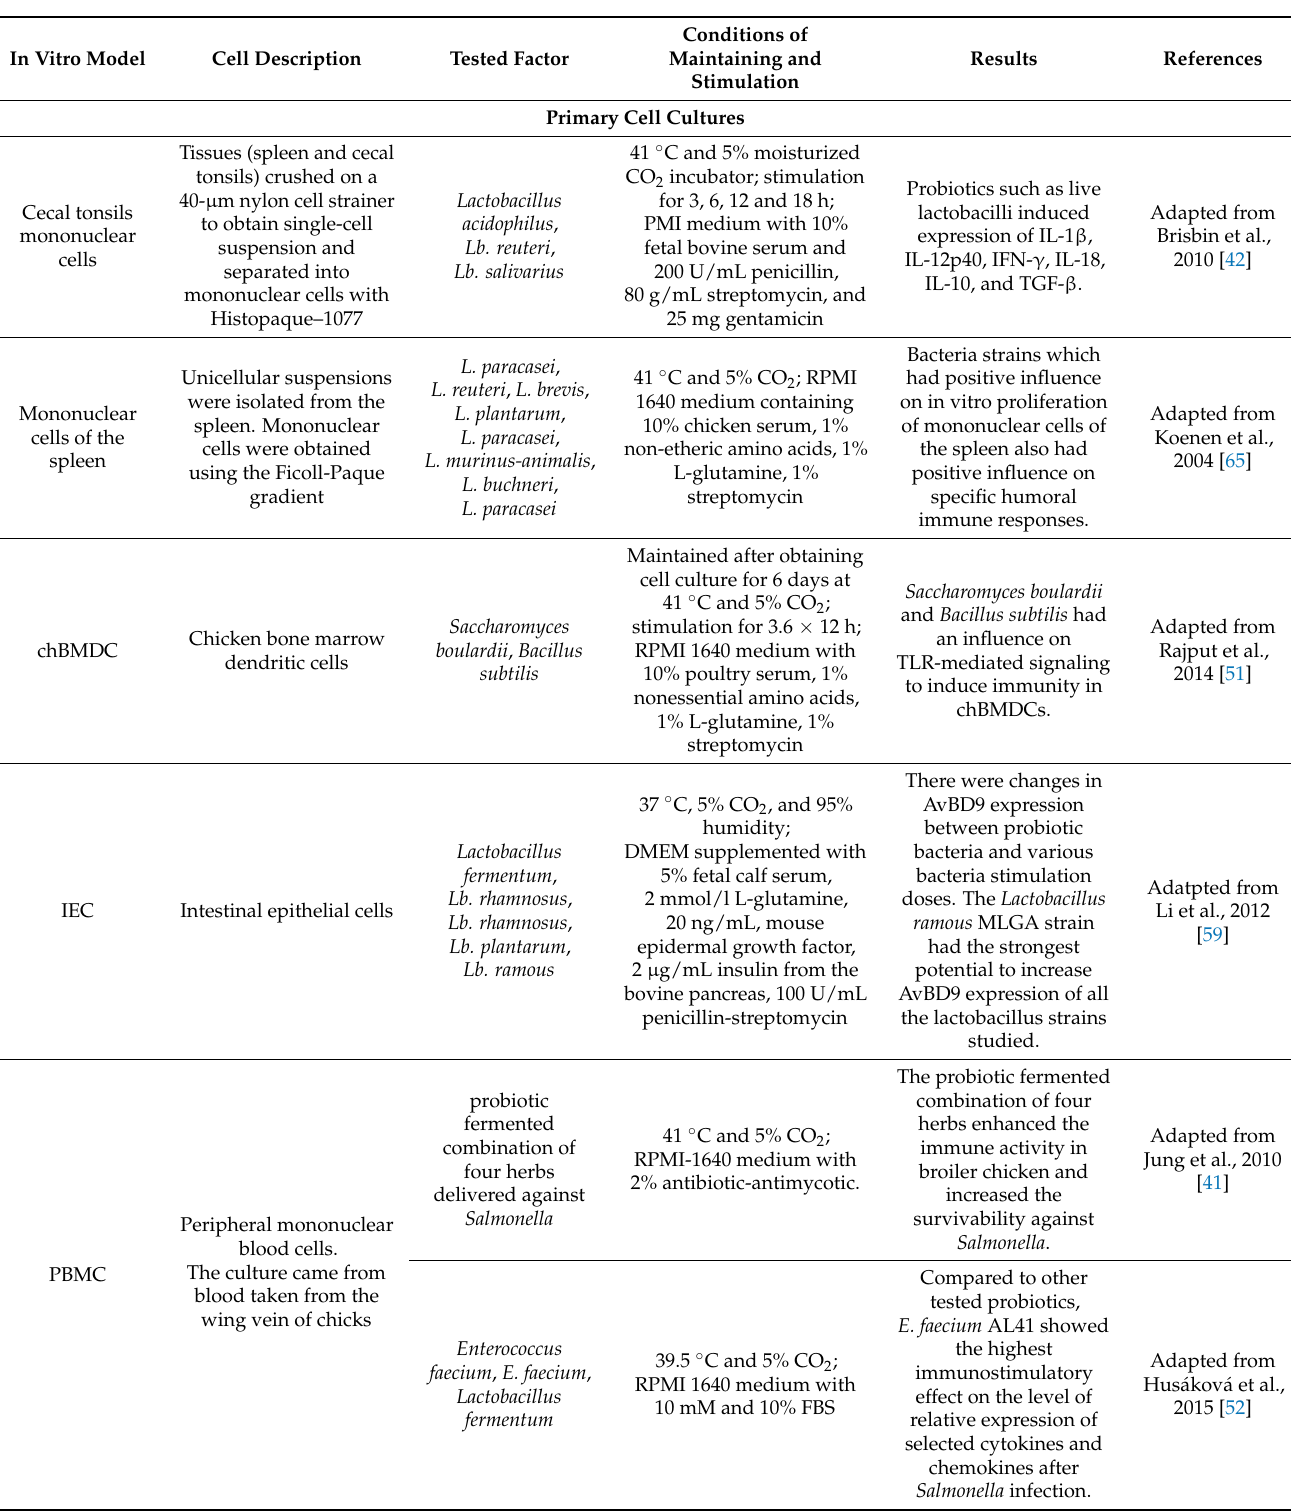
Table 2. Overview of primary bird cell